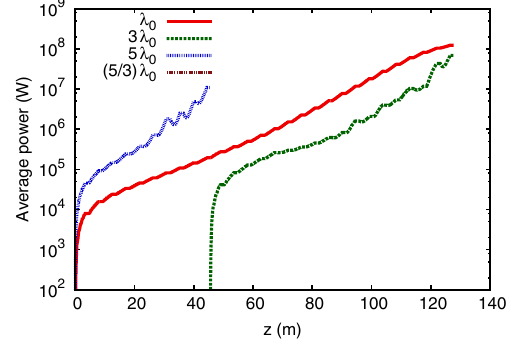
FIG. 5. Average power produced at various wavelengths as a function of distance for the “ reversed ” example.